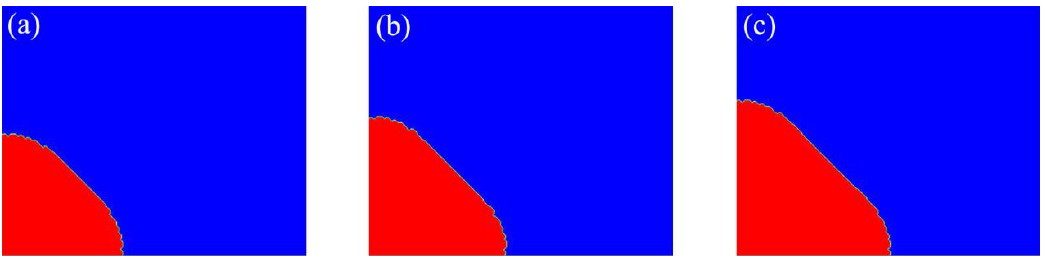
Figure 2. Simulation results for q ( φ ) with δ = 0.01 and λ = 3 in the domain of 613 µ m × 500 µ m: ( a ) t = 0.04s; ( b ) t = 0.05s; ( c ) t = 0.06s.